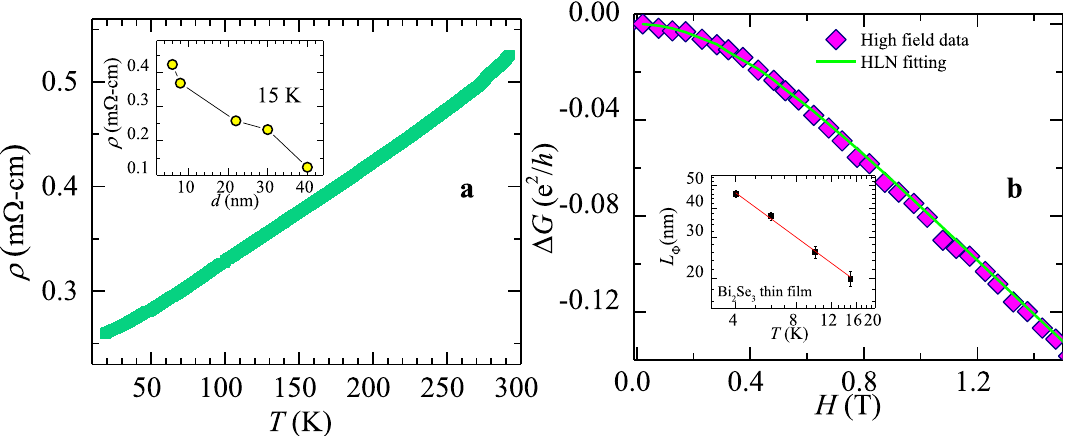
Figure 1. Magneto-transport properties of Bi 2 Se 3 thin film. ( a ) Shows the temperature dependence of the resistivity of Bi 2 Se 3 thin film. Inset figure shows the thickness dependence of resistivity at 15 K. ( b ) Figure shows the magneto-conductance in units of ( e 2 / h ), at 15 K. Green solid line shows fitting of the data to HLN equation (see text for details). Inset figure shows the behaviour of the electron phase coherence length, L Φ , as function of T on a log–log scale. The red line shows the linear behaviour (see text for